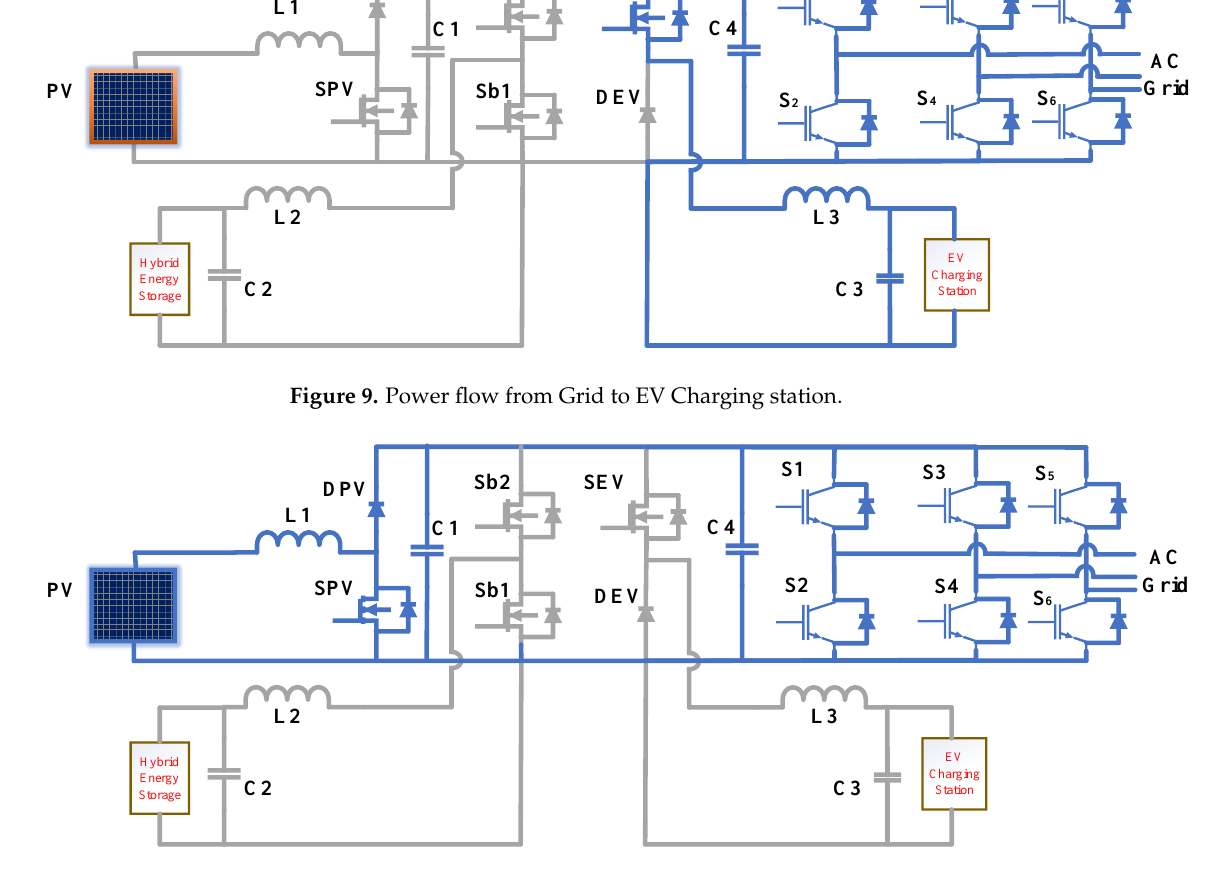
Figure 10. Power flow from PV to Grid.